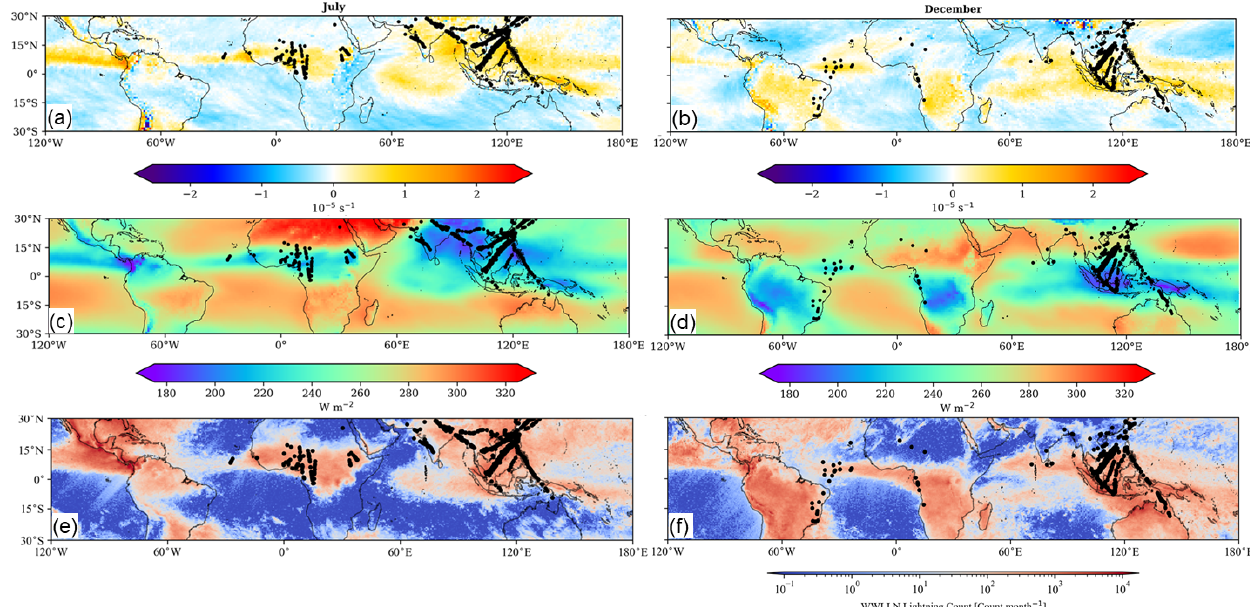
Figure 12. Spatial distribution of the monthly average of horizontal wind divergence at 200hPa, determined from ERA5 reanalysis (2011– 2019) during (a) July and (b) December. Spatial distribution of the monthly average of outgoing longwave radiance for (c) July and (d) De- cember. Spatial distribution of the monthly lightning flash count, derived from the World Wide Lightning Location Network (2011–2018) for (e) July and (f) December. The EIEs for July and December are shown as black